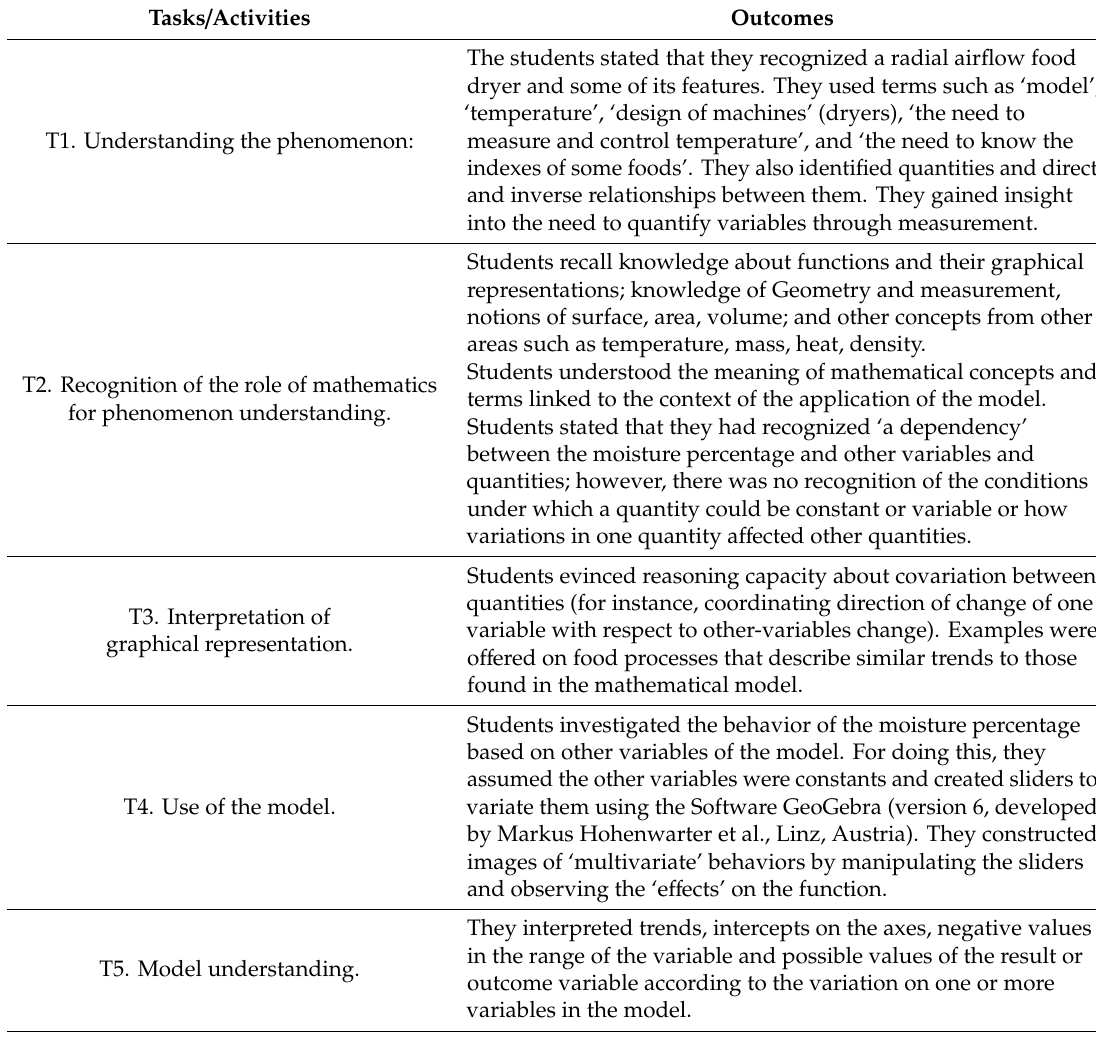
Table 1. Summary of